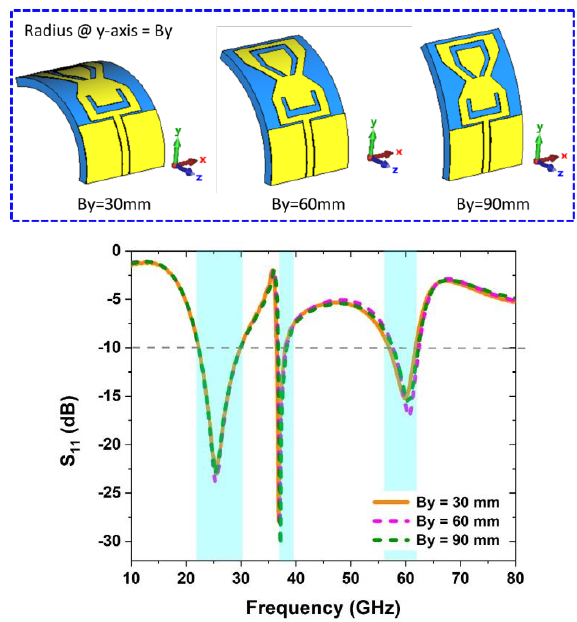
Figure 6. Antenna bending analysis along y -axis.